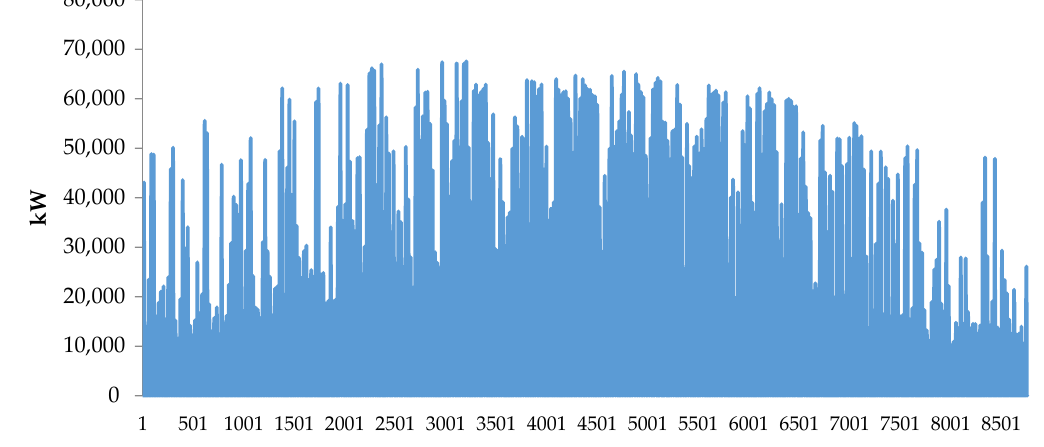
Figure 13. Alternating Current ( AC) output of the system.